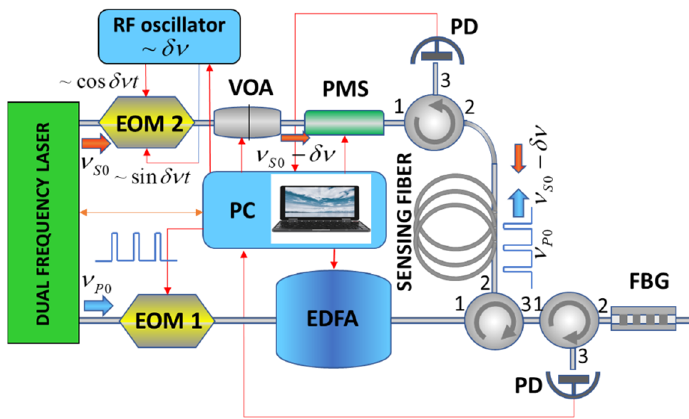
Figure 1. The experimental BOTDA setup.